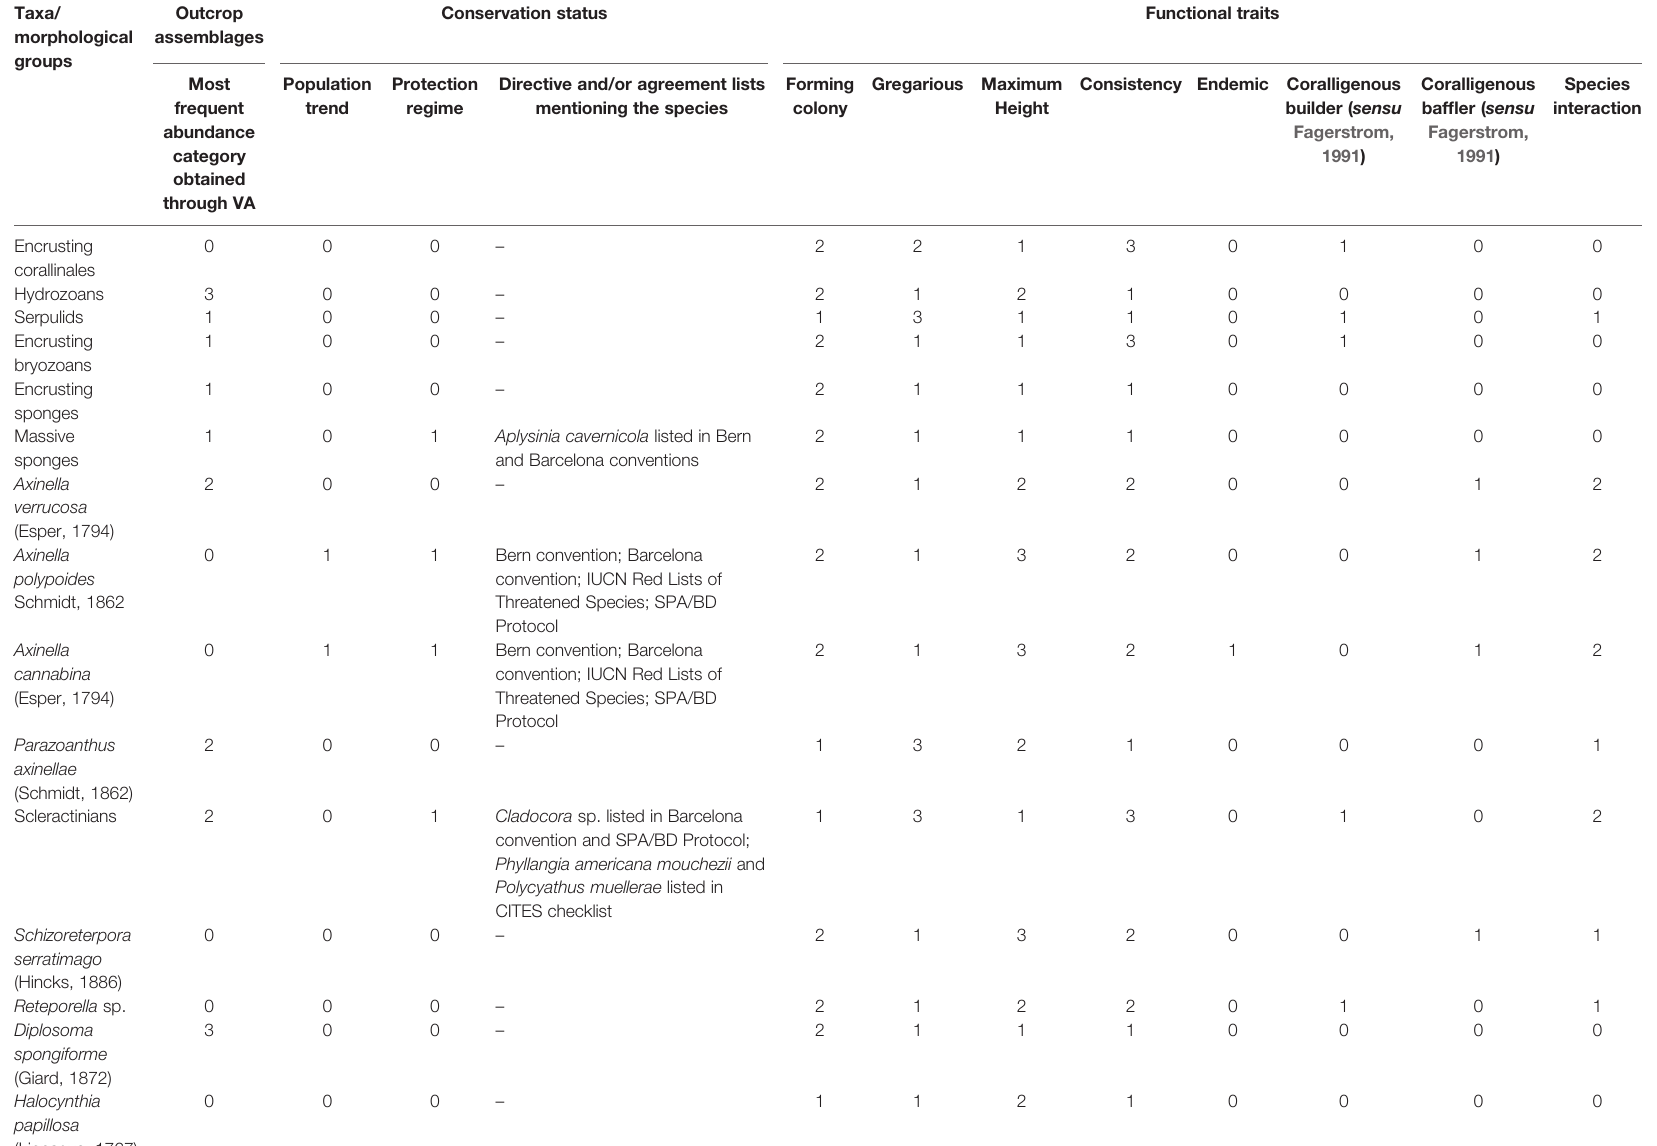
TABLE 1 | List of the values assigned to each of the taxa/morphological groups found on the 30 interfered outcrops and summed to calculate the relocation score used to identify the primary ecological/conservation concern organisms. Taxa/